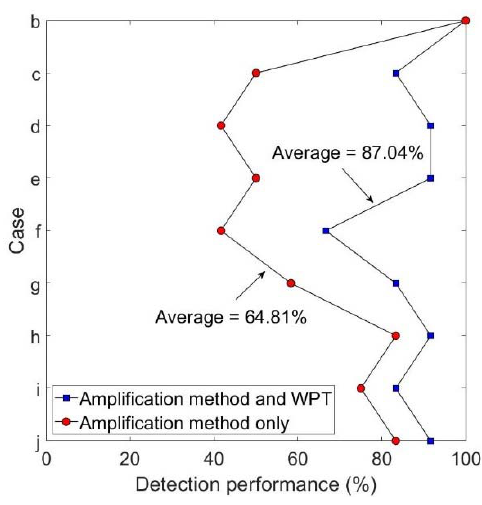
Figure 19. Comparison of detection performance between method 1 (amplification method and WPT) and method 2 (amplification method only).